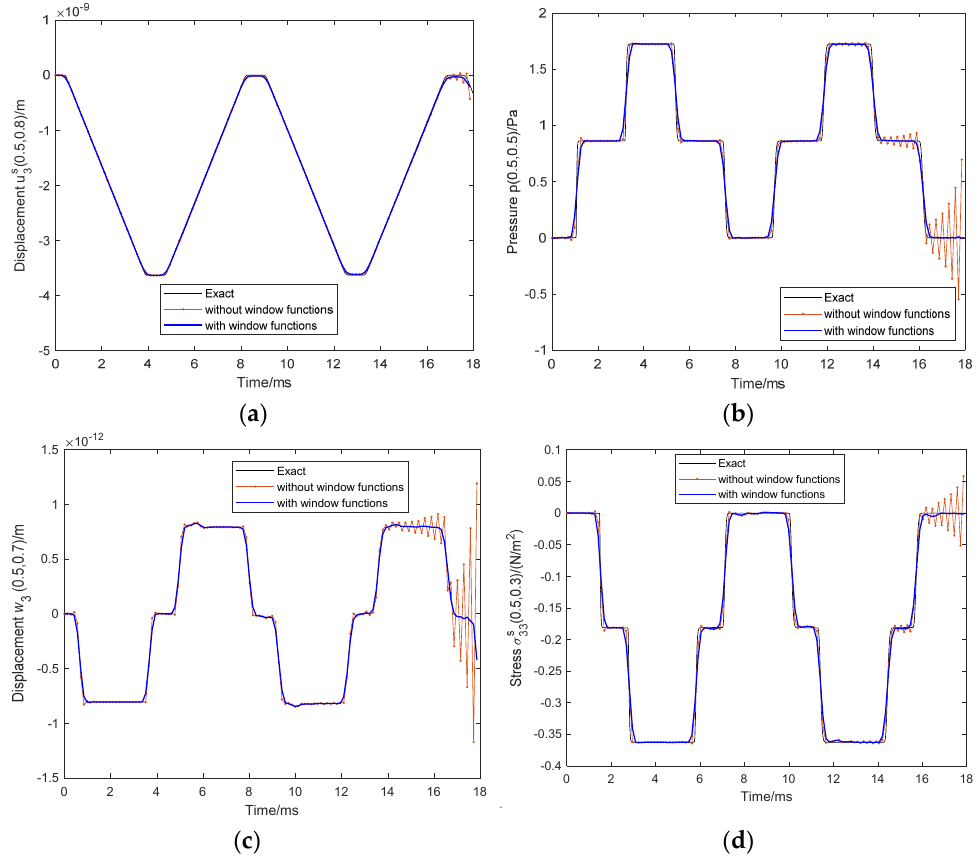
Figure 2. Time history of ( a ) u s